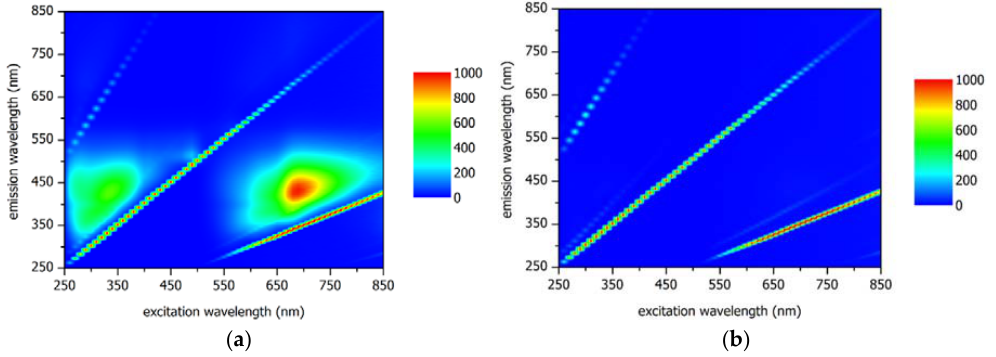
Figure 4. Examples of EEMs from RO: ( a ) feed and ( b ) 1st pass permeate.